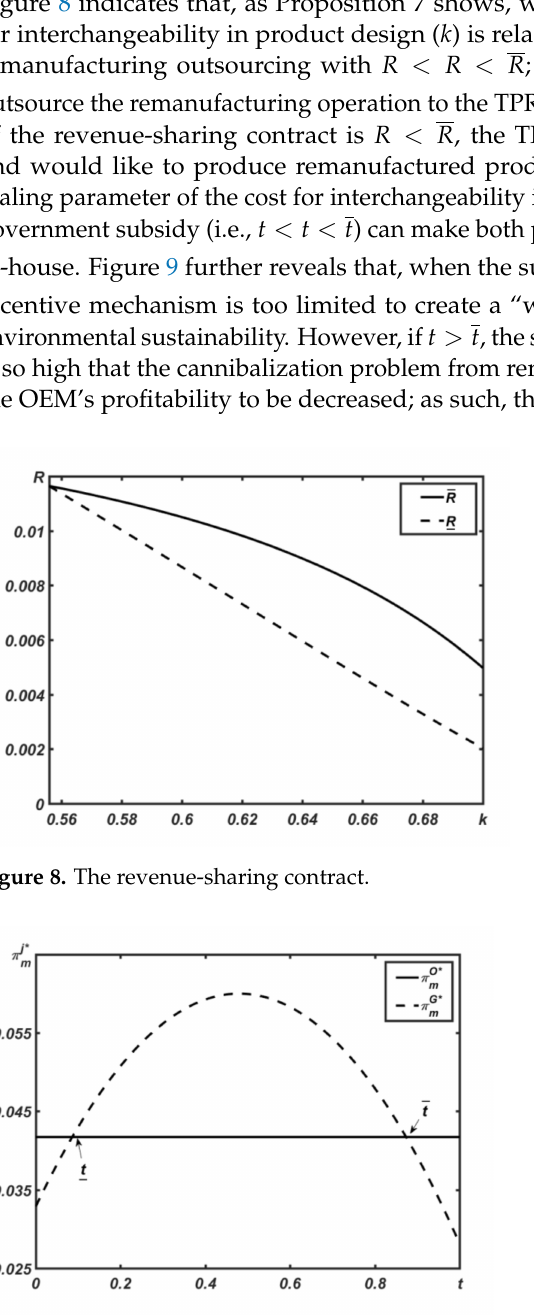
Figure 9. A subsidy-incentive